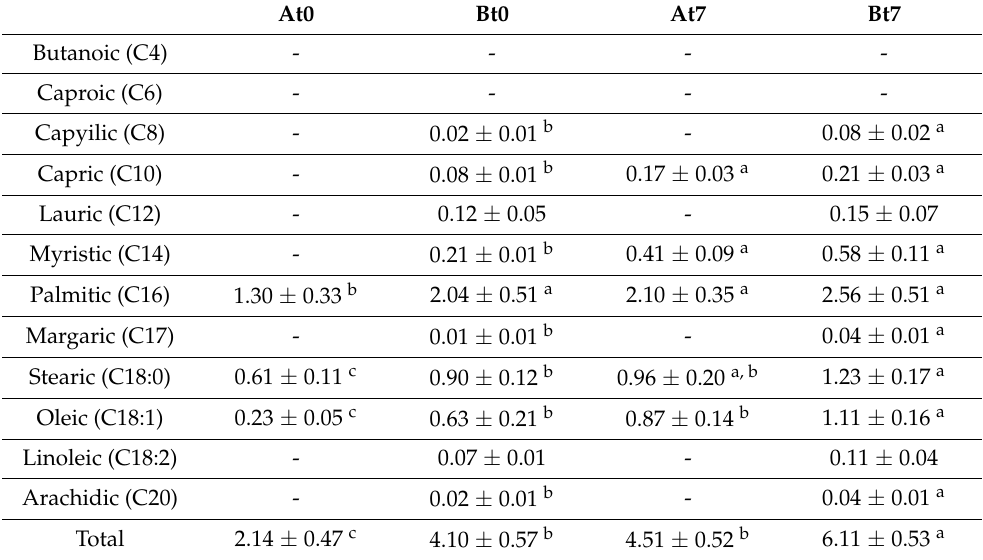
Table 4. Free fatty acids (mg g − 1 fat ± standard deviation) of the cheese samples from trials A and B at 0 and 7 days refrigerated storage. Values in the same row bearing different superscripts are different at p <